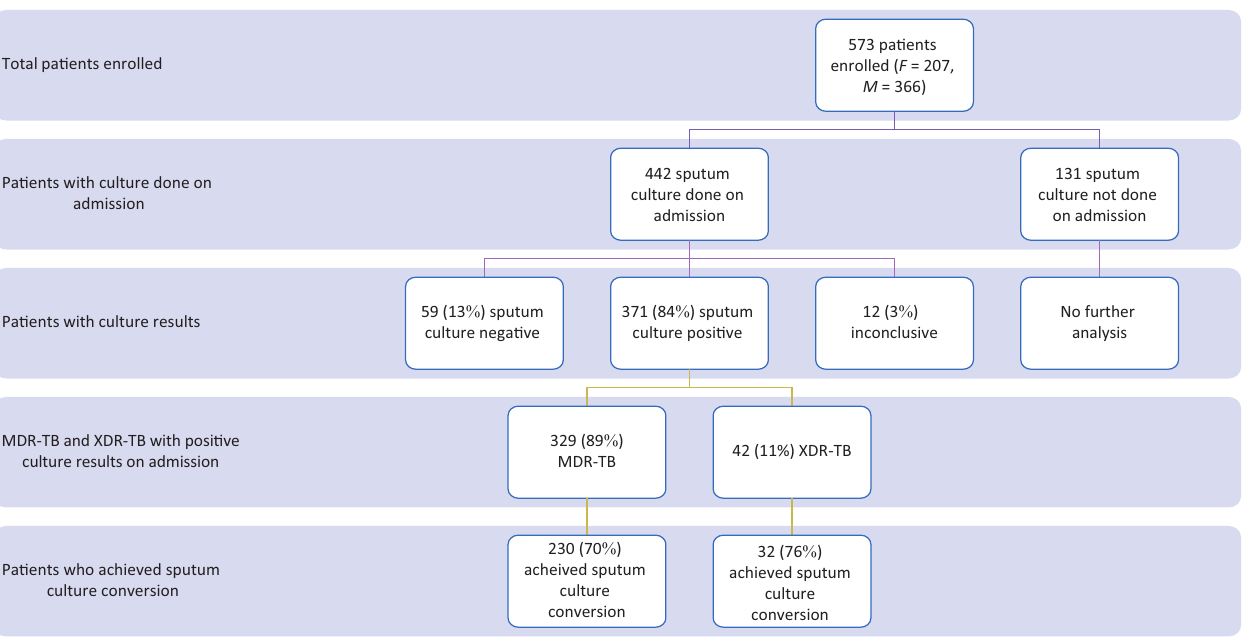
FIGURE 1: Number of participants included in the analysis of time to sputum culture